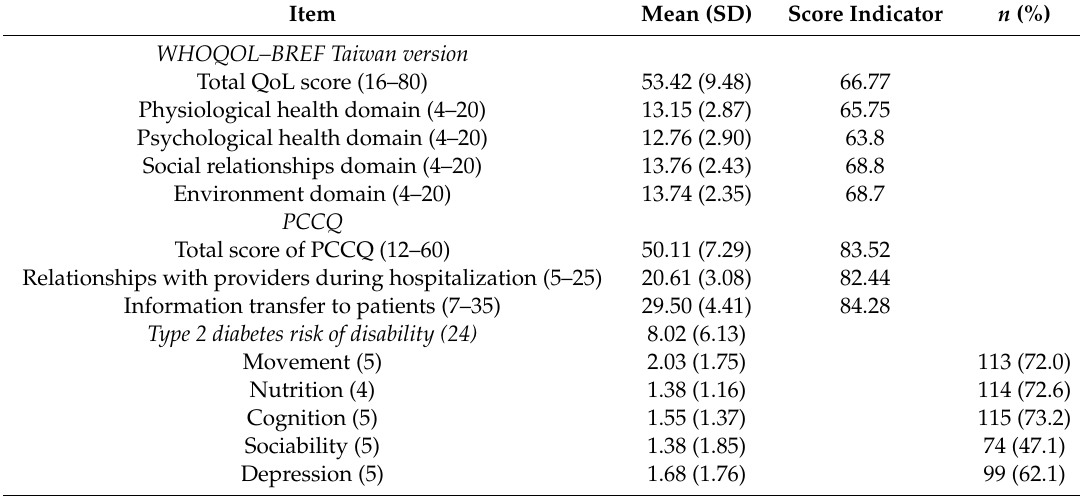
Table 1. World Health Organization Quality of Life Scale: Brief (WHOQOL-BREF) Taiwan version, Patient Continuity of Care Questionnaire (PCCQ) scores, and risk of disability in patients with